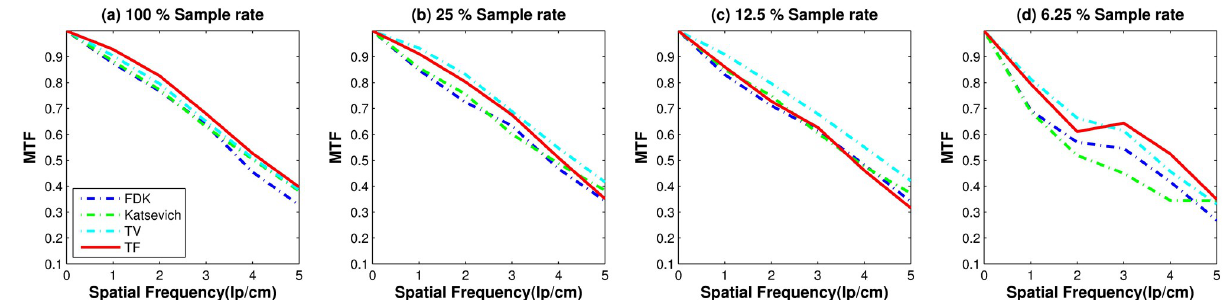
Fig 10. Image resolution measure: Results of MTF curves with different reconstruction algorithms over various sampling levels. The red line on the Fig 6(a 0 ) is used to compute the LSF and MTF.